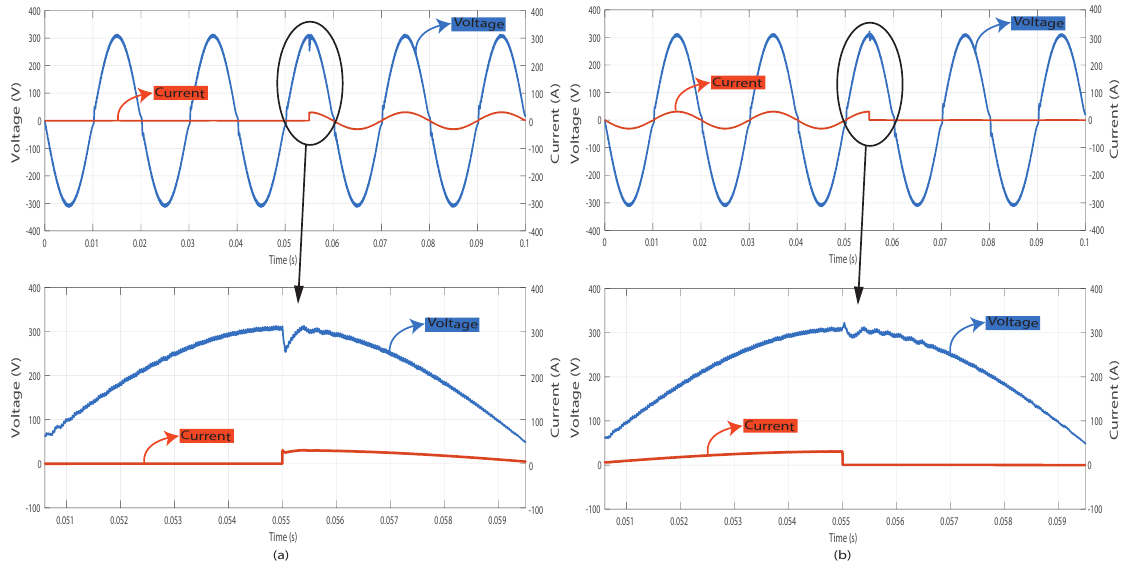
Figure 6. Simulation based SM controller. ( a ) Transient response of the system when additional load is connected. ( b ) Transient response of the system when additional load is removed.